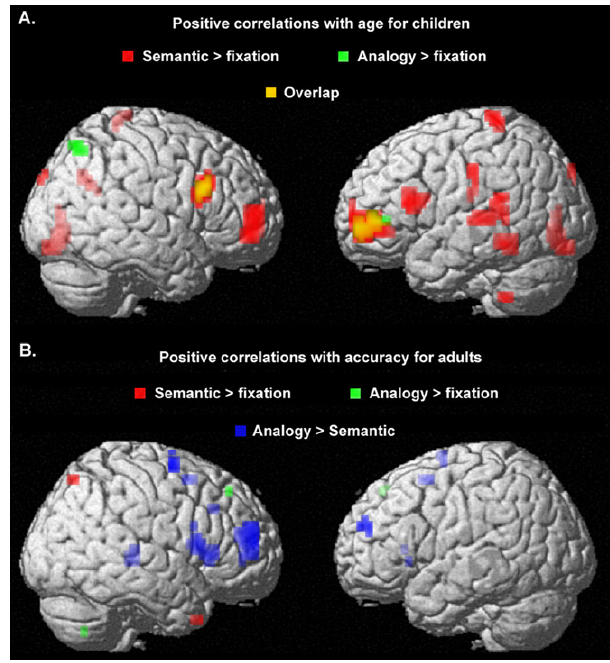
Figure 3. Whole-brain multiple regression analyses are displayed here. (A) Positive correlations with age from 6-13 were observed for semantic tri- als (shown in red) in a number of regions, including left RLPFC (BA 10; − 27, 50, 0), left VLPFC (BA 45; − 42, 18, 16) and right DLPFC (BA 9; − 48, 18, 26), and regions in temporal, parietal, motor, and visual regions. For analogy trials, positive correlations with age from 6–13 were observed only in left RLPFC, right VLPFC, and right superior parietal lobule (BA 7; 36, − 66, 52). (B) Adults who exhibited higher accuracy on analogy trials exhibited greater differential activation between analogy and semantic trials in bilateral VLPFC and RLPFC, as well as several other regions. The most prominent cluster was observed in right RLPFC (BA 10; 27, 45,